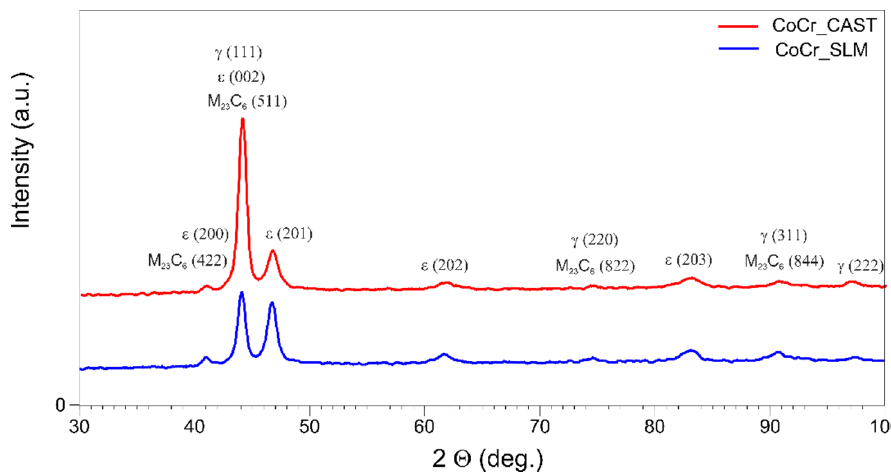
Figure 3. X-ray di ff raction pattern of the tested samples. Figure 3. X-ray diffraction pattern of the tested samples.